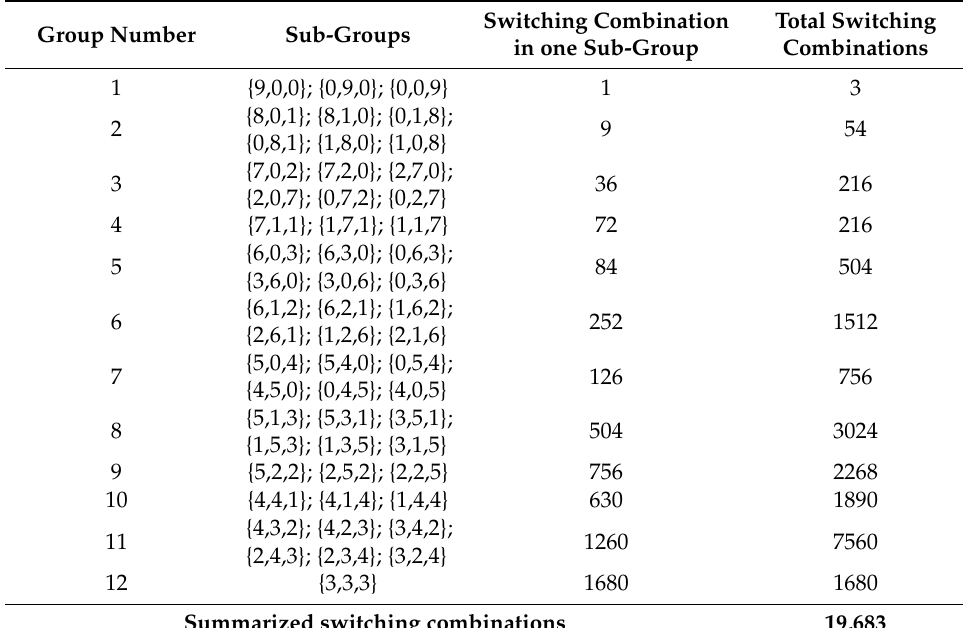
Table 1. Rotating space vectors in the three-to-nine-phase